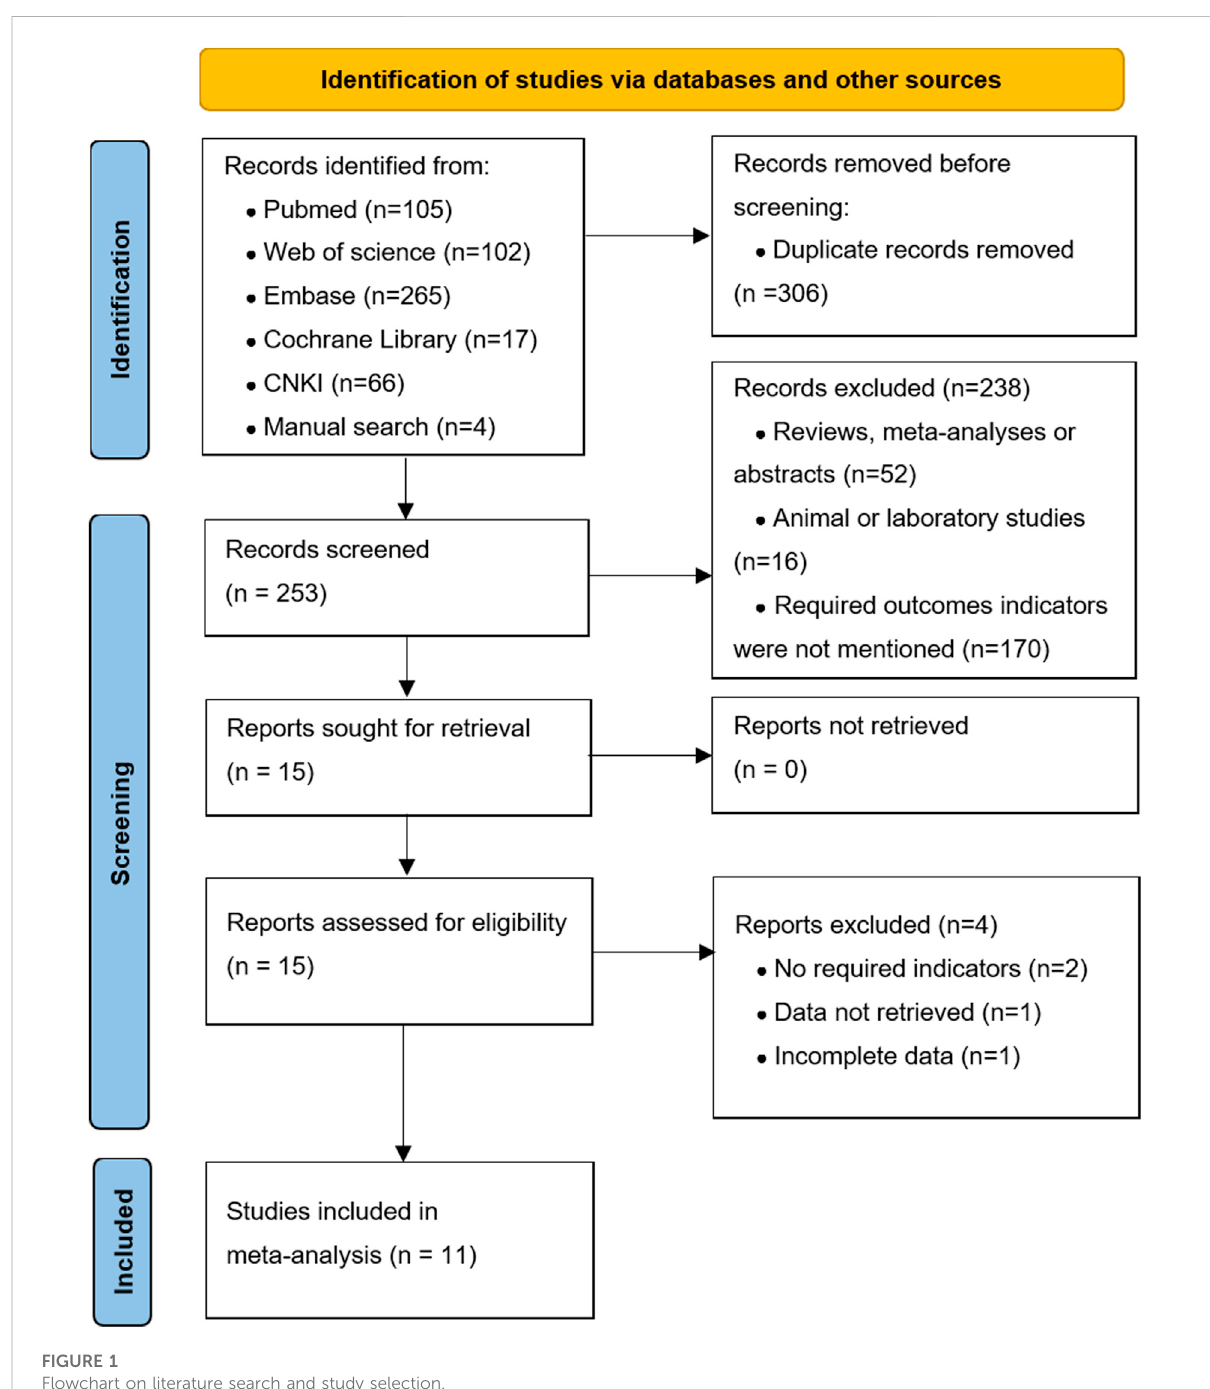
FIGURE 1 Flowchart on literature search and study